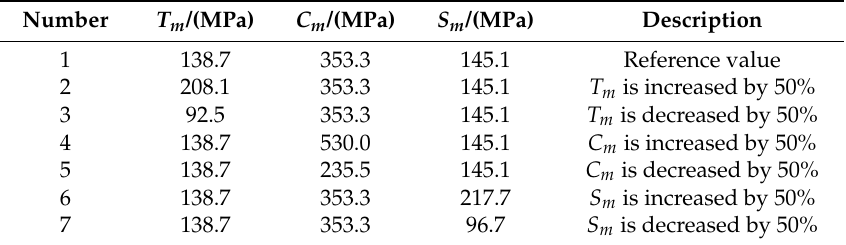
Table 4. Variation ranges of the matrix-dominant micro strength for the sensitivity analysis.